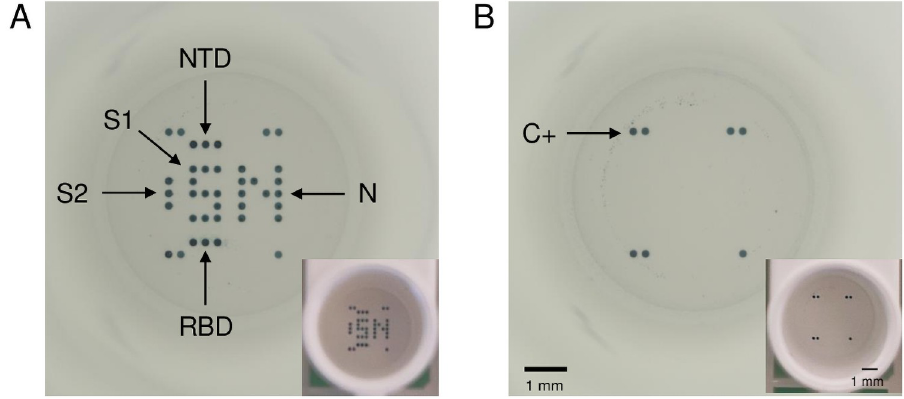
Fig 1. Full well pictures pictures obtained with the microplate reader (SciReader 1 ) or with a phone camera (in insert) after incubation with the CoViDiag 1 assay. (A) Positive sample presenting antibodies against the